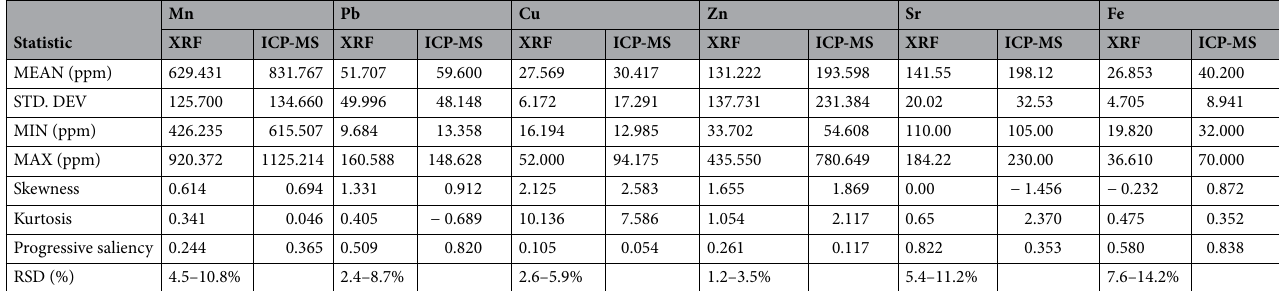
Table 1. Statistical characteristics of metal detection in soil.